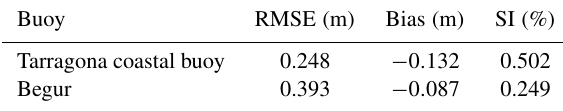
Table 1. Statistics of the agreement between numerical significant wave height fields (SWAN model) and observations in terms of root mean square error (RMSE), bias and scatter index (SI) for the con- trol points at the southern and northern coastal